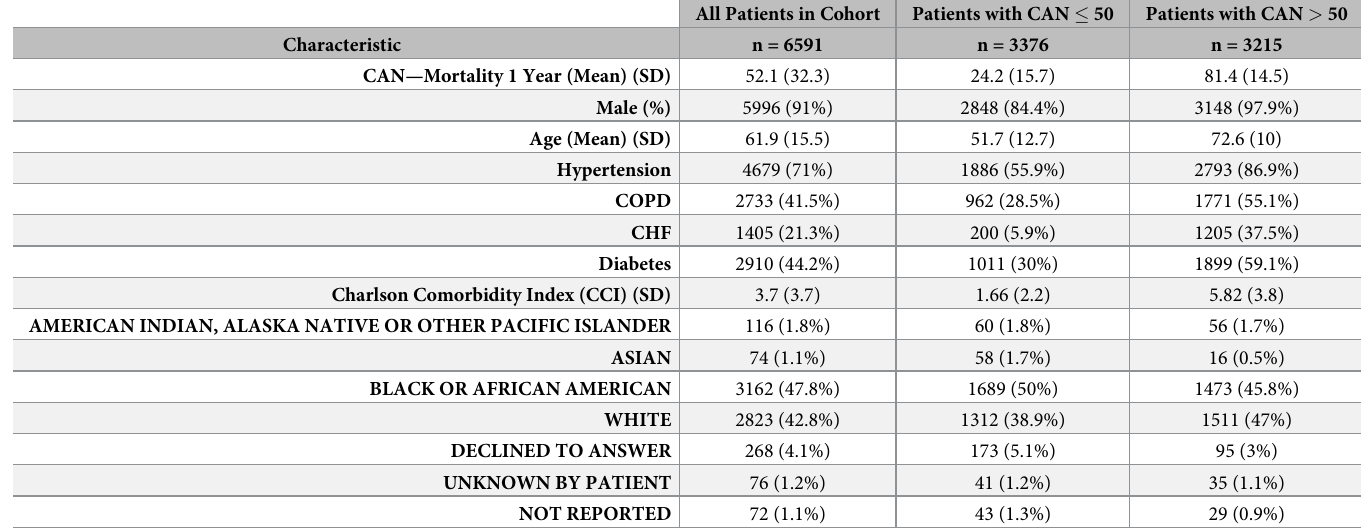
Table 1. Characteristics of Veterans identified with a positive COVID -19 diagnosis by lab test at VA, and CAN score, from March 2, 2020 to May 26,